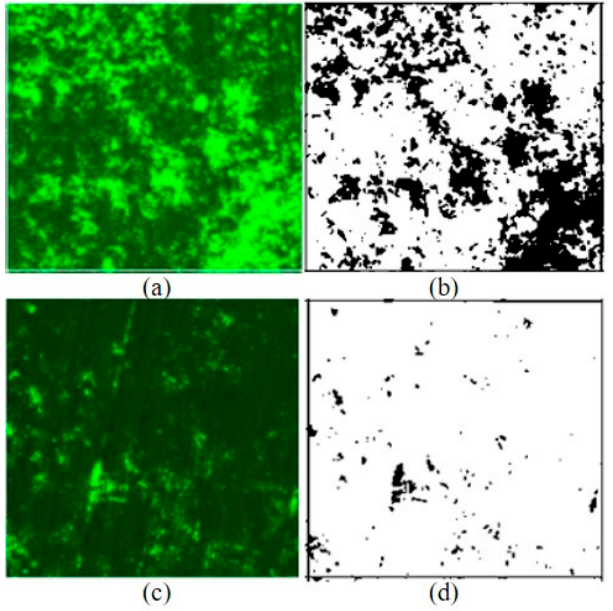
Figure 6. Representative images of biofilms. ( a ) Green fluorescence control biofilm, ( b ) binary converted control image (black area corresponds to the biofilms), ( c ) after one hour electric-field- treated green fluorescence image, and ( d ) binary converted one hour electric-field-treated image (black area corresponds to the biofilms).